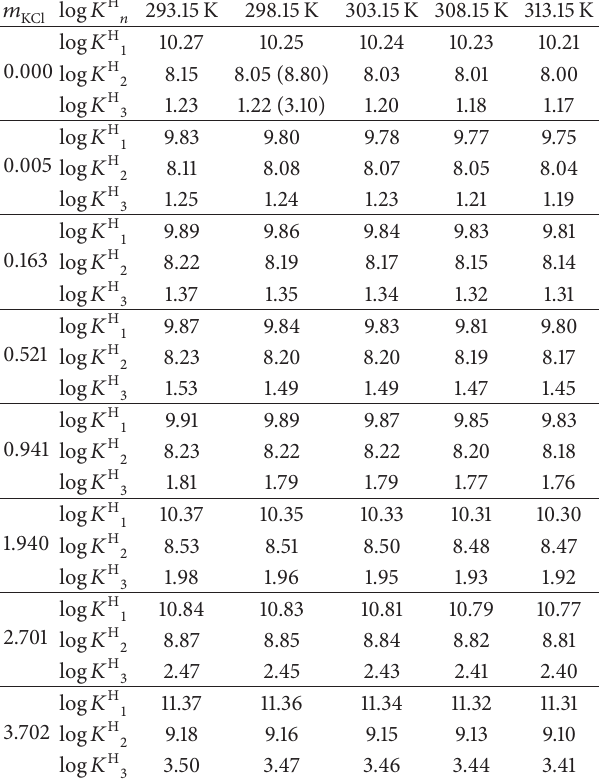
Table 3: Experimental protonation constants ((log 𝐾 H 1 ± 0.02 ), (log 𝐾 H 2 ± 0.02 ), and (log 𝐾 H 3 ± 0.07 )) of L3, in KCl of different ionic strength and at different temperatures.